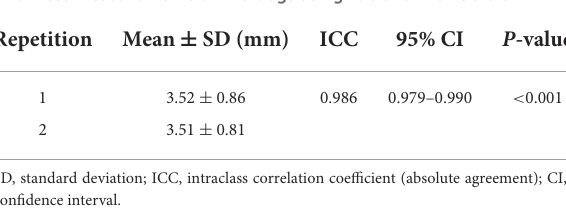
TABLE 3 Intraobserver (observer A) reliability for the total urethral thickness measurements of 115 dogs using ICC and their 95% CI.